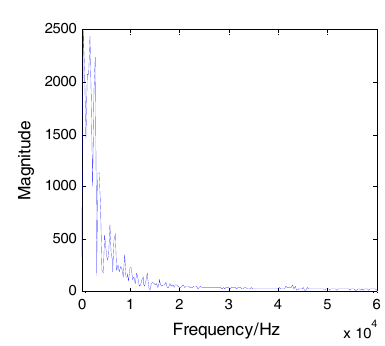
Figure 5. Frequency spectrum of S 2 .